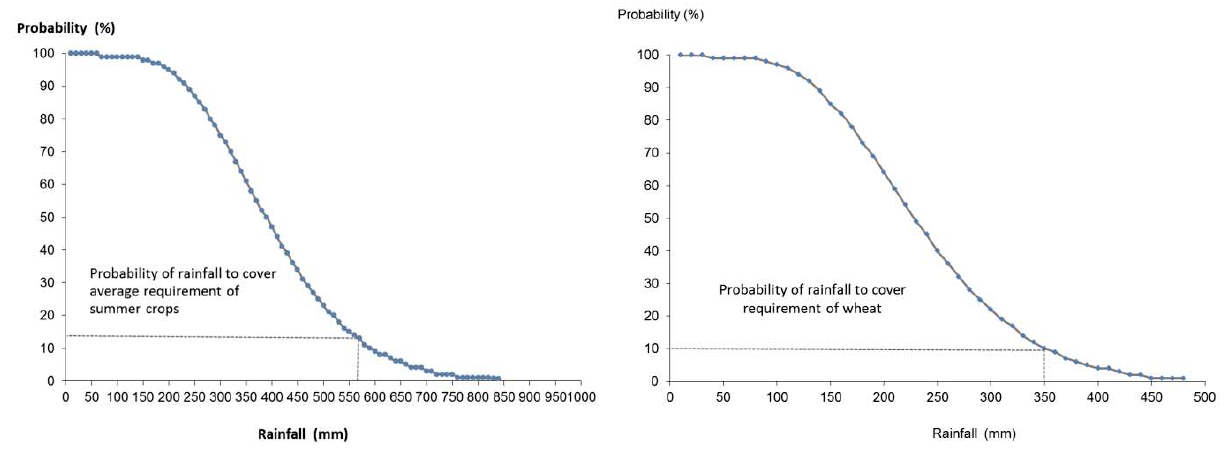
Figure 1. Probability of occurrence of historical rainfall (1921–2009) in summer crops (October to February) and winter crops (July to November). The arrows indicate the probability of the occurrence of rainfall that covers the crops’ minimum requirements (560 mm and 350 mm for summer and winter crops